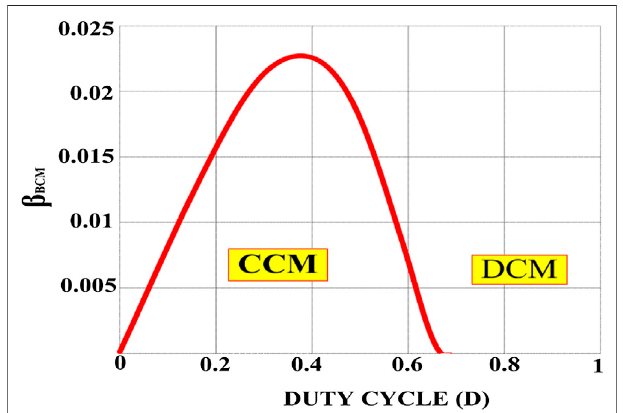
FIGURE 6 | Boundary normalized inductor time constant Vs duty cycle